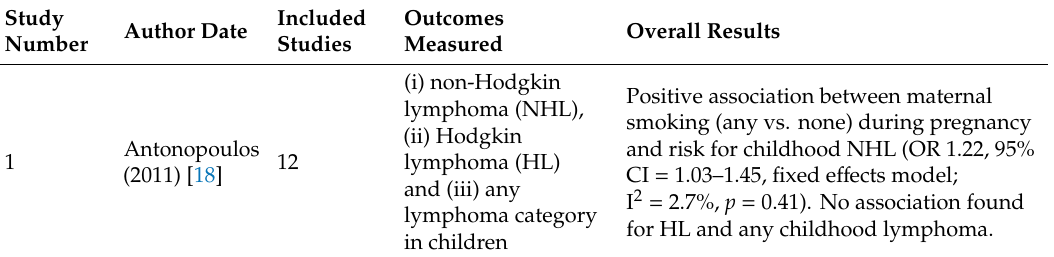
Table 2. Risks of maternal smoking for foetus or child below or equal to two years of